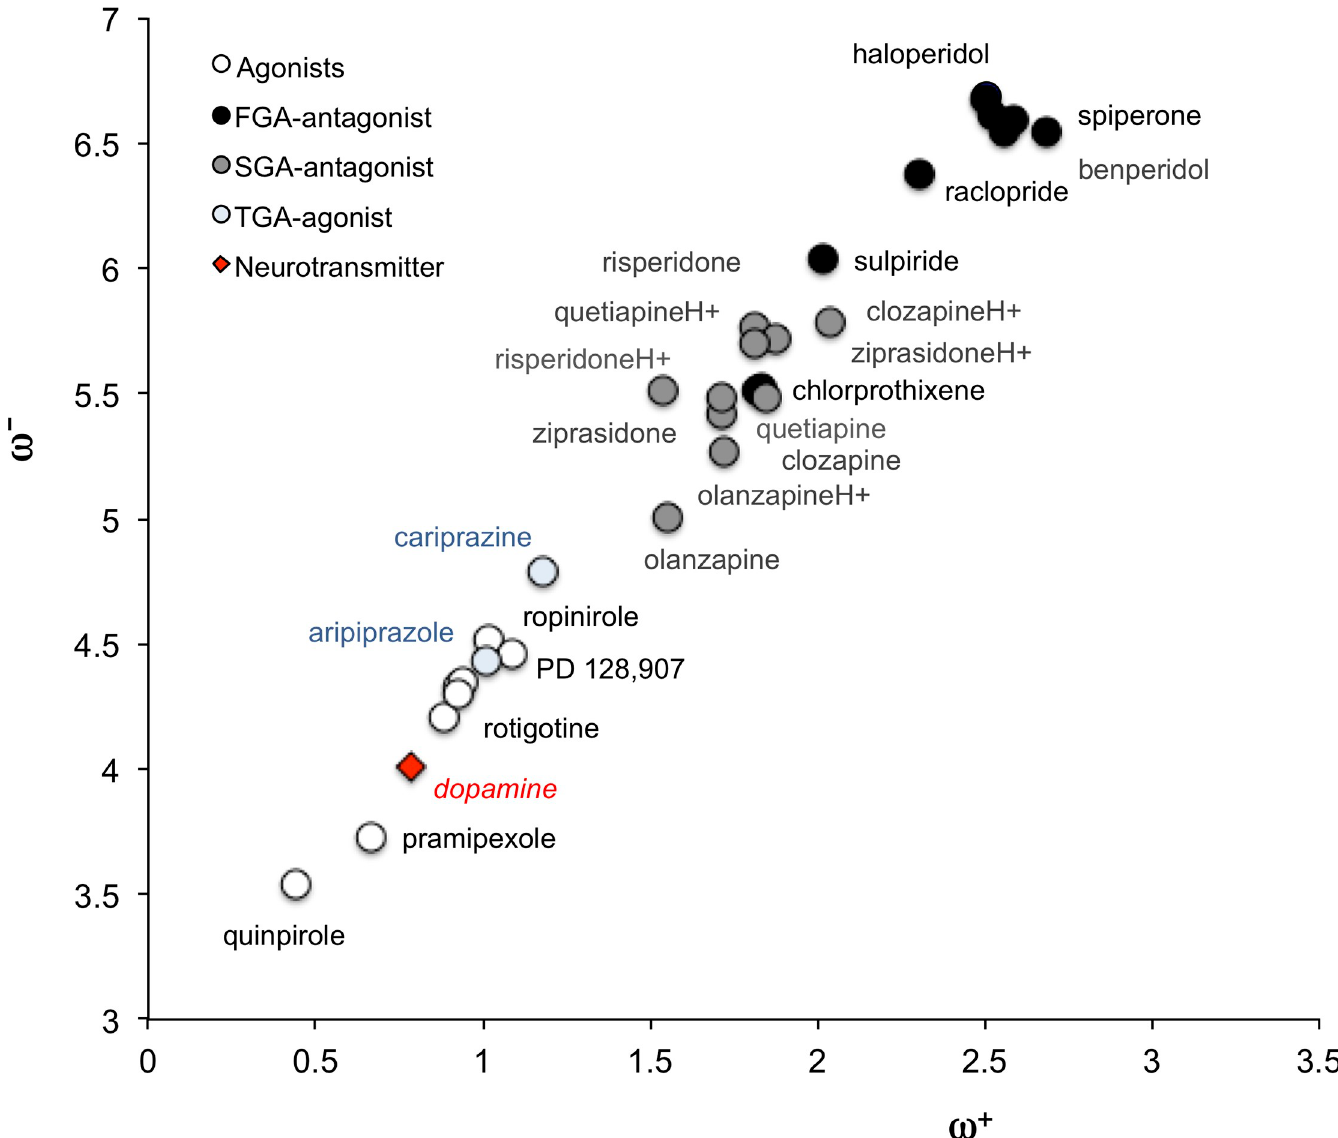
Fig 3. DAM of molecules under study. Donor-Acceptor Map of antagonists and agonists. Dopamine is included for comparison.